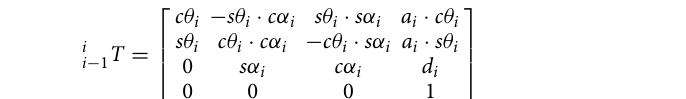
where i i − 1 T is the homogeneous transformation matrix of joint i − 1 to i , s θ i and c θ i stand in for sin (θ i ) and cos (θ i ) , respectively. By substituting each row of data in Table 1 into Eq. (22), the homogeneous transformation matrix of each joint can be obtained, as shown in Eq. (23).